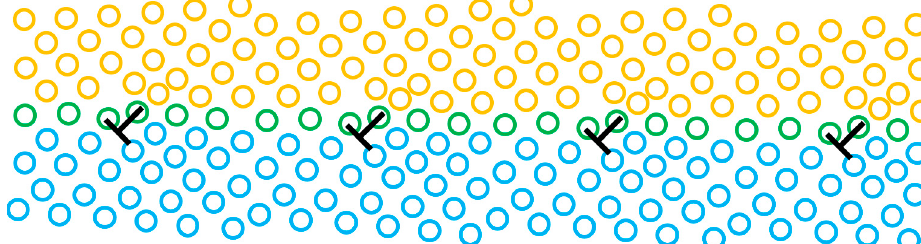
Figure 1. An illustration of a low angle grain boundary.